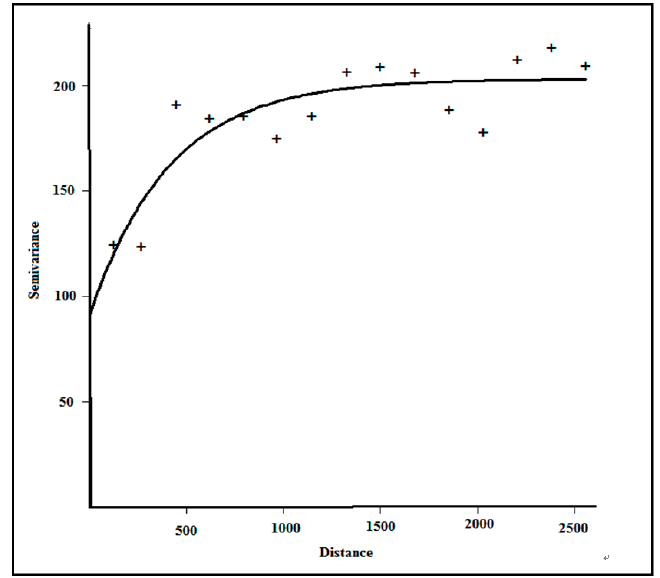
Figure 4. Experimental (crosses) and fitted model (line) variogram of regression residuals for use in predicting LC.